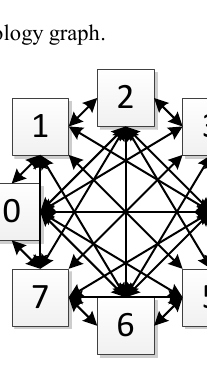
Fig. 6. Ring topology graph.